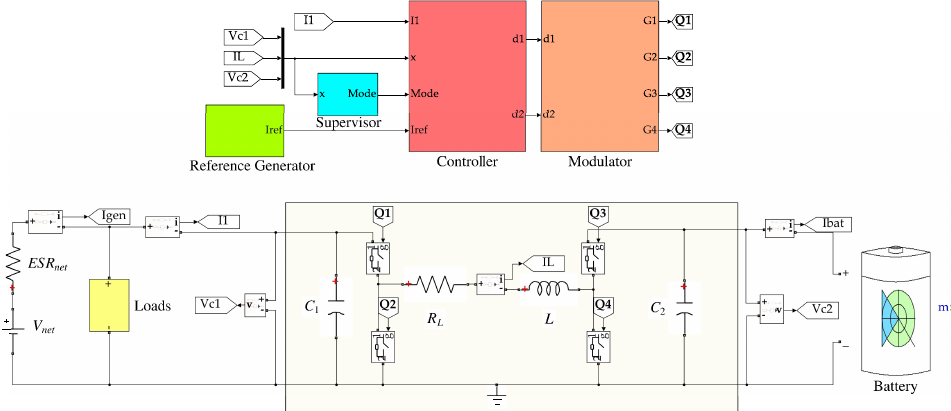
Figure 4. MATLAB/Simulink/SimPowerSystem simulation model.